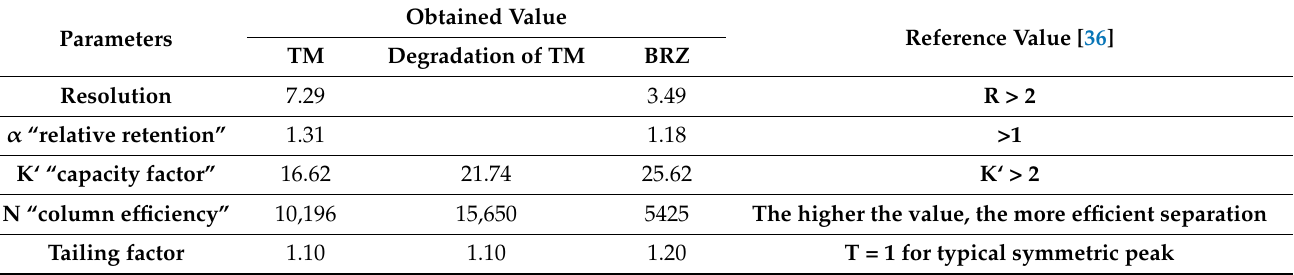
Table 6. System Suitability Results for the RP-HPLC method